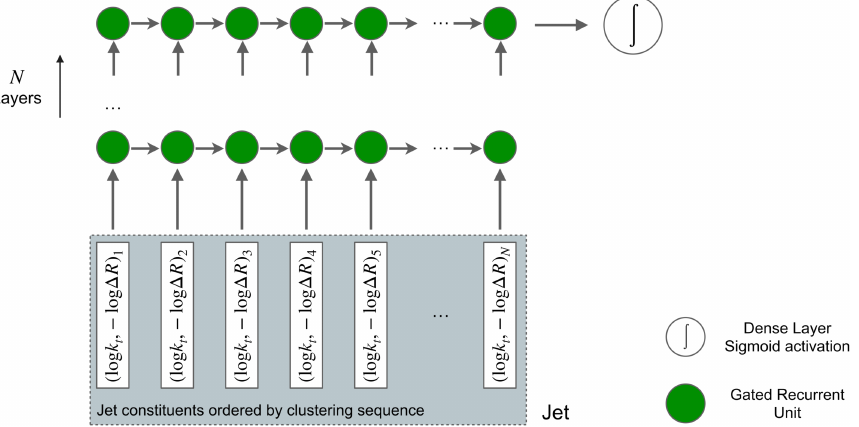
Figure 8 . Diagram of the Recurrent Neural Network used for jet classification from sequences of coordinates of the jet constituents in the Lund